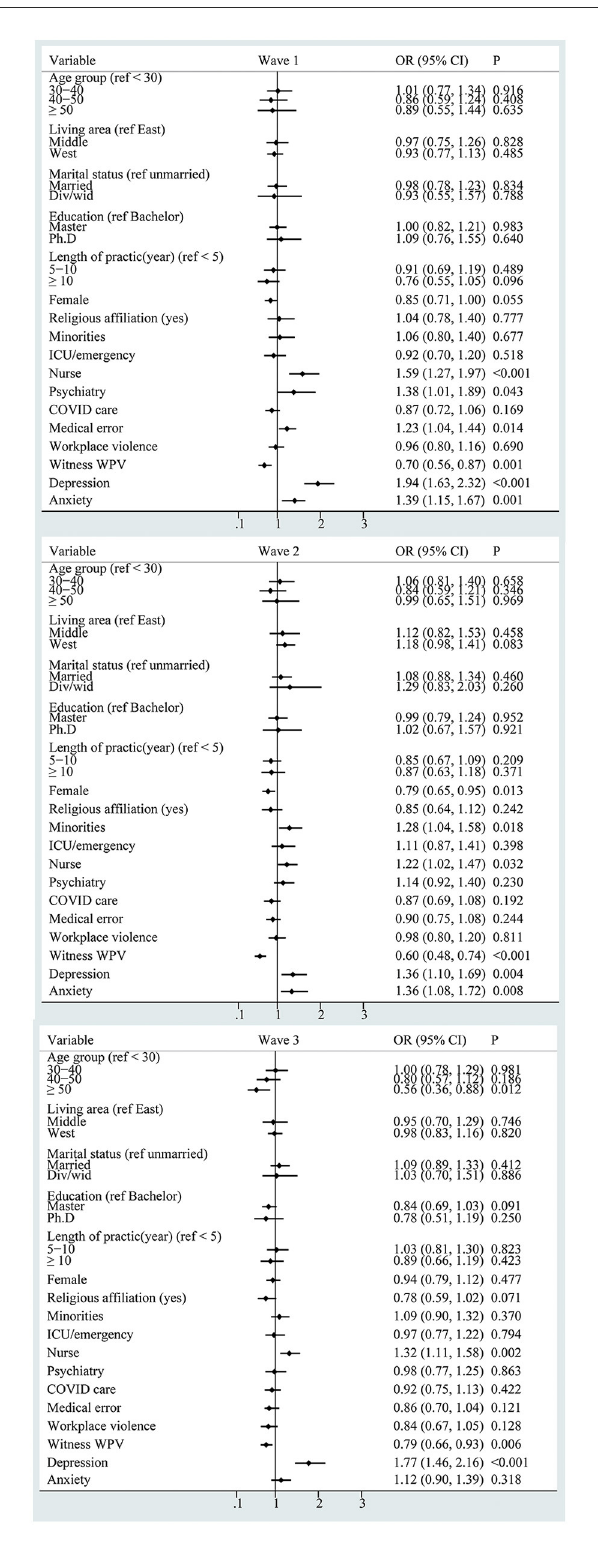
FIGURE3 Forest plot of the correlators of declined personal accomplishment (WPV: workplace